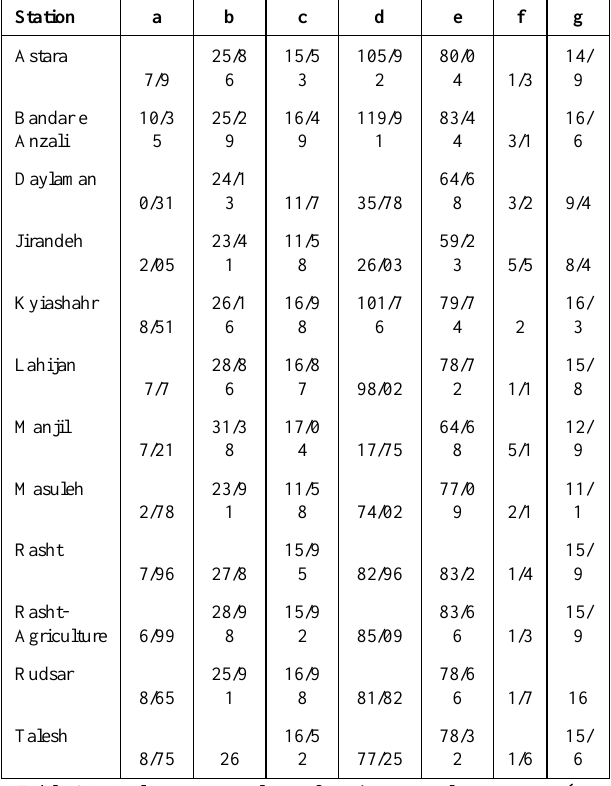
Table 8. Yearly average values of environmental parameters (a= minimum of daily temperature, b=maximum of daily temperature, c=average temperature, d= precipitation, e=average humidity, f= average wind speed and g= average vapor